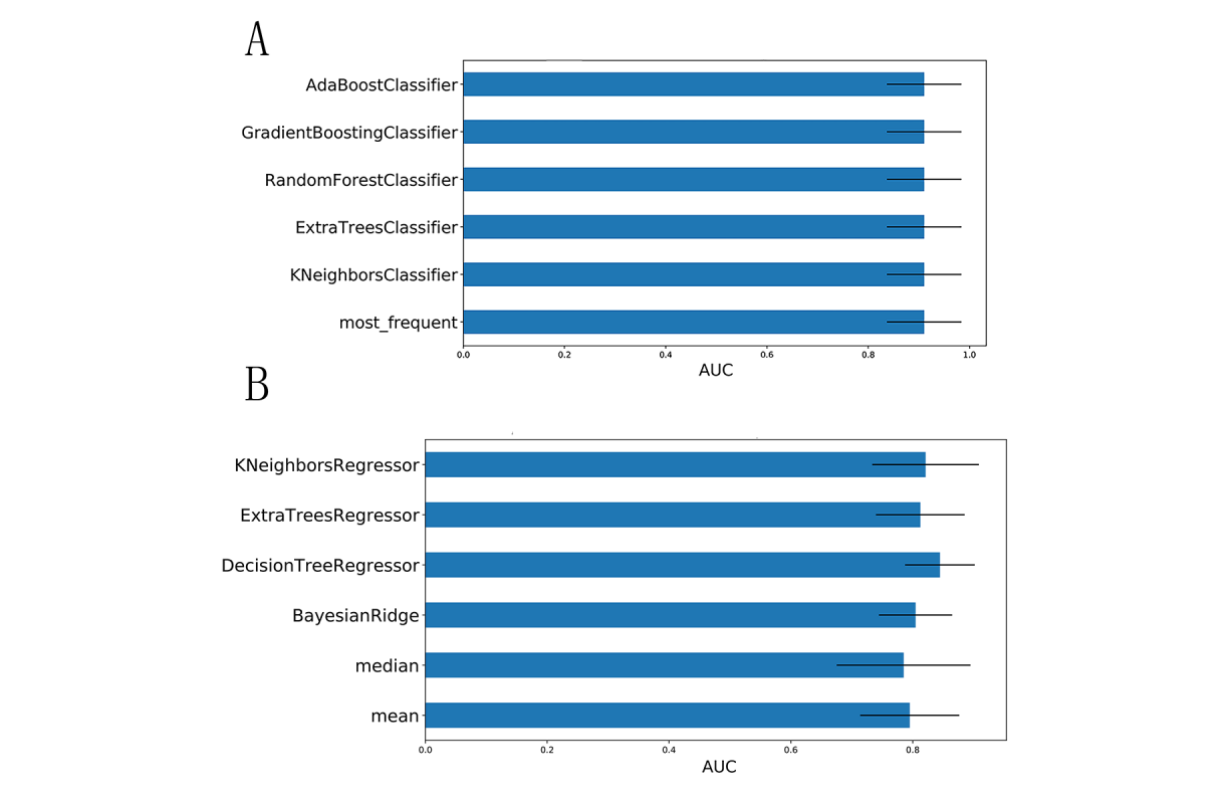
Figure 1. (A) Comparison of the AUC values obtained after using logistic regression as a carrier and filling in discrete features with multiple missing filling methods. (B) Comparison of the AUC values obtained after continuous feature filling by multiple missing filling methods using logistic regression as a carrier. AUC: area under the receiver operating characteristic